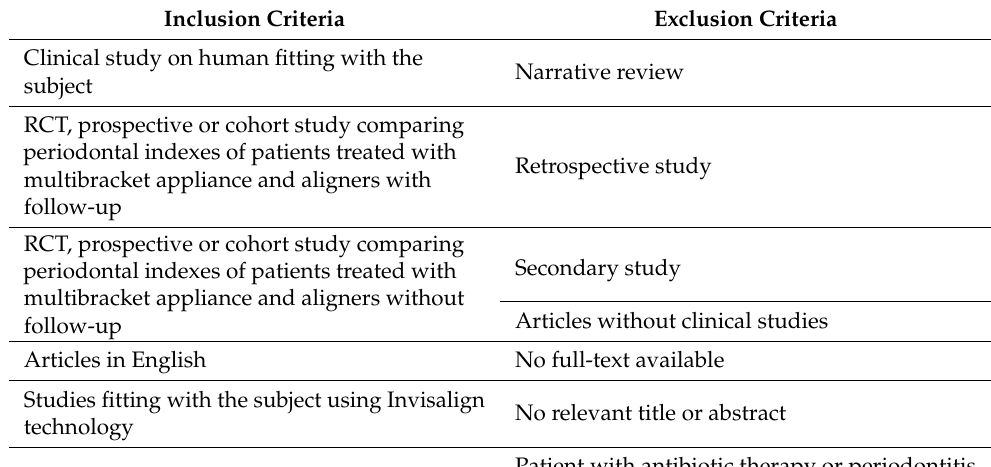
Table 2. Eligibility